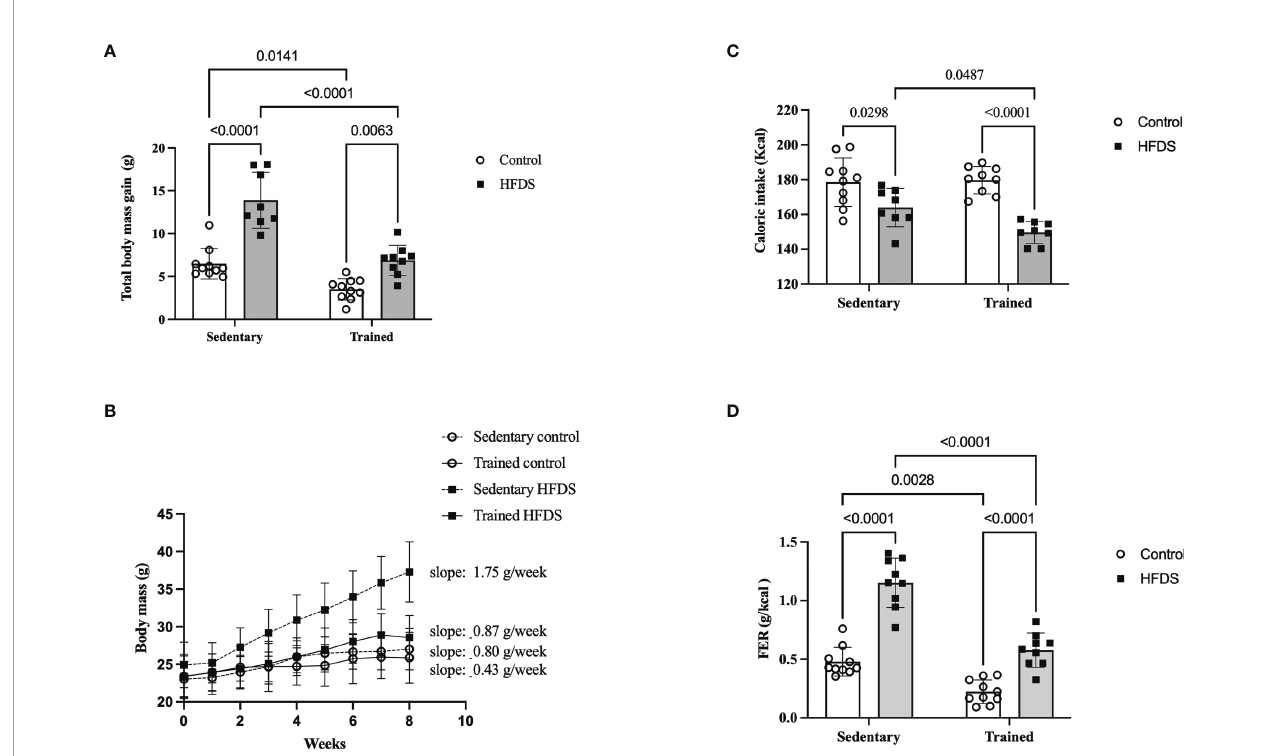
FIGURE 3 | Effects of eight weeks of exercise training and HFDS diet on metabolic parameters in male C57BL6J mice. (A) Total body mass gain after eight weeks. C vs . HFDS, HFDS vs . HFDSTR, CTR vs . HFDSTR (P<0.01). (B) Changes in body mass over the eight-week intervention. C vs . CTR (P<0.05), C vs . HFD (P<0.001), HFDS vs . HFDSTR and CTR vs . HFDSTR (P<0.05). (C) Total caloric intake; C vs . HFDS, HFDS vs . HFDSTR (P<0.01). (D) FER: C vs . CTR, C vs . HFDS, HFDS vs . HFDSTR and CTR vs . HFDSTR (P<0.001). Data were analyzed by two-way ANOVA as described in the Materials and Methods. All data presented as the mean±SD.